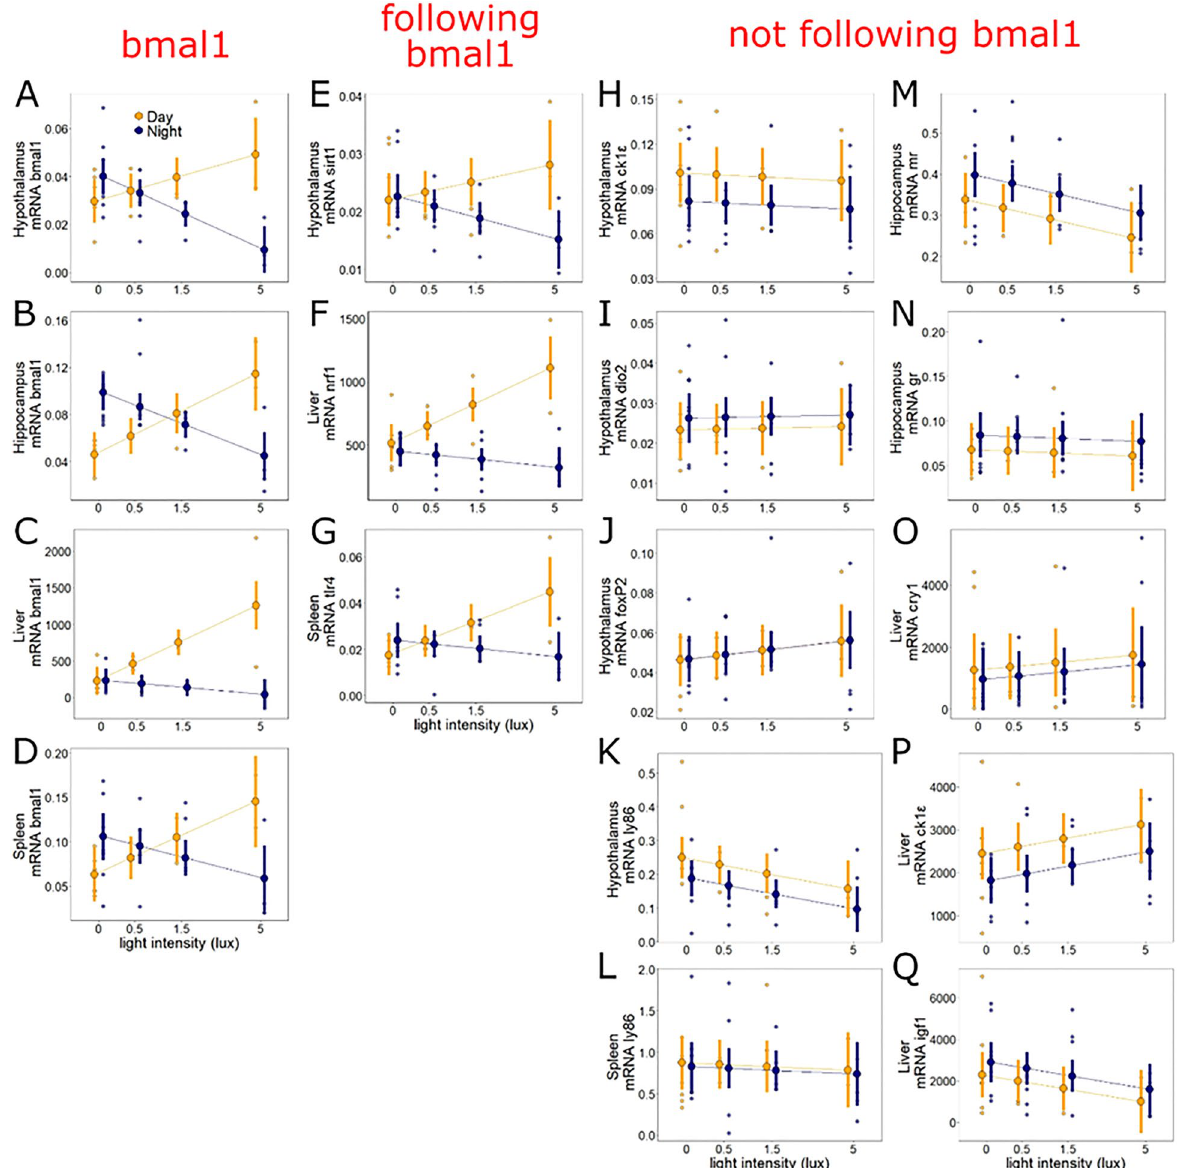
Figure 5. ALAN effects on gene expression are gene-specific. ALAN does not equally affect all physiological systems. ALAN effects on BMAL1 ( A – D ) were paralleled by those on three additional genes in the hypothalamus ( SIRT1 ), liver ( NRF1 ) and spleen ( TLR4 ) ( E – G ), but not by other genes analysed across tissues ( H – Q ). Shown are log-transformed mRNA levels, separated by sampling time (mid-day: yellow; midnight: dark blue). Large symbols ± SEM connected by lines represent model estimates, whereas small symbols depict raw data points (N = 34